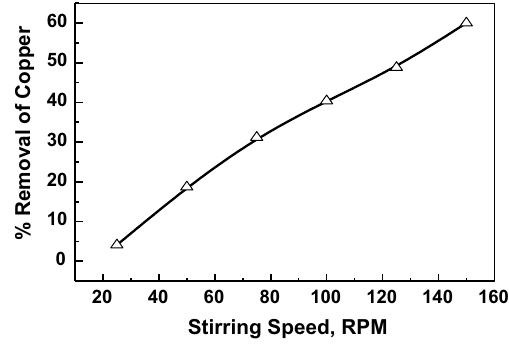
Fig. 7 Effect of variation in stirring speed